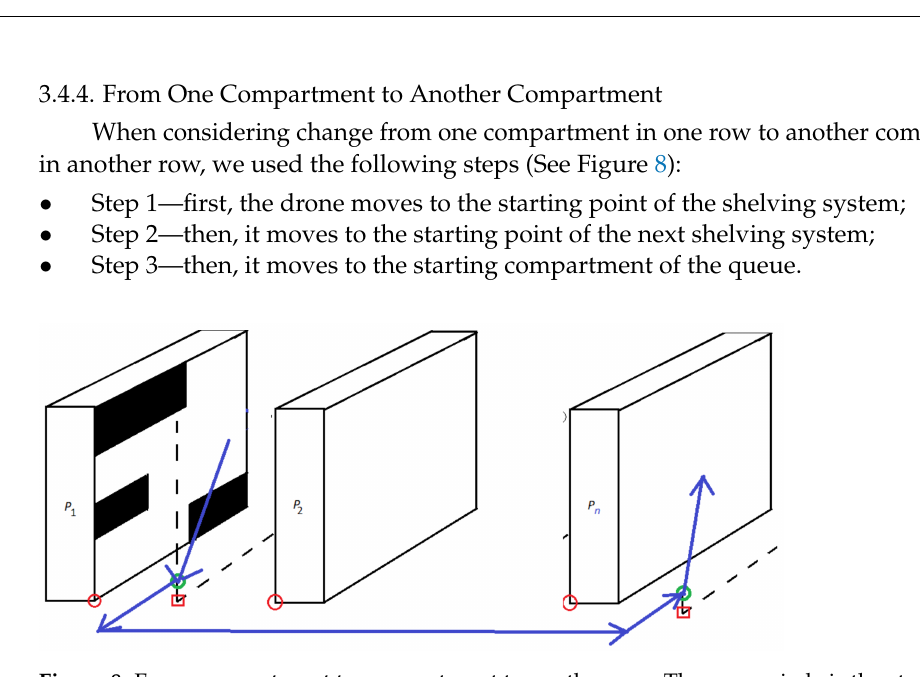
Figure 8. From compartment to compartment to another row. The green circle is the start position of the examination; the blue line is the route of drone; the red square is the center of the corridor (reference point). The red circles are referece